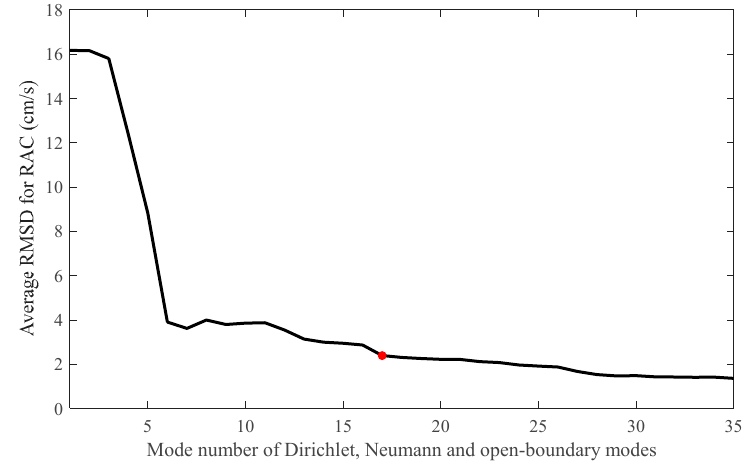
Figure 3. Average root-mean-square-difference (RMSD) of the observed and inverted range-averaged currents (RACs) plotted with respect to the mode number. The red dot indicates the position where the optimal mode number of 17 was determined.